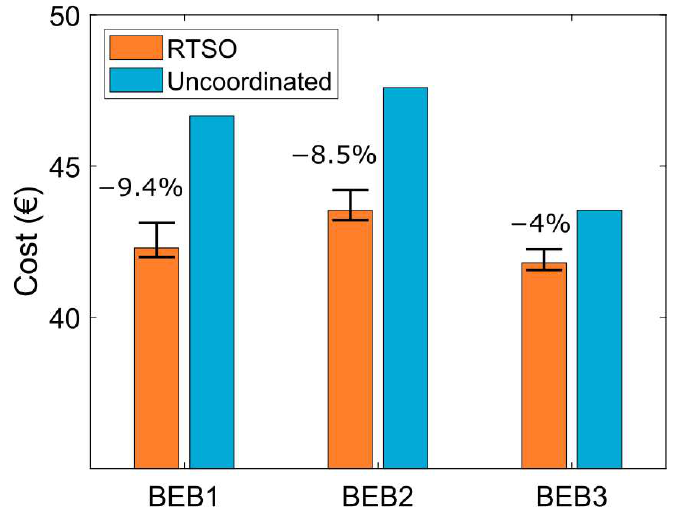
Figure 5. Cost comparison of charging with RTSO and without.